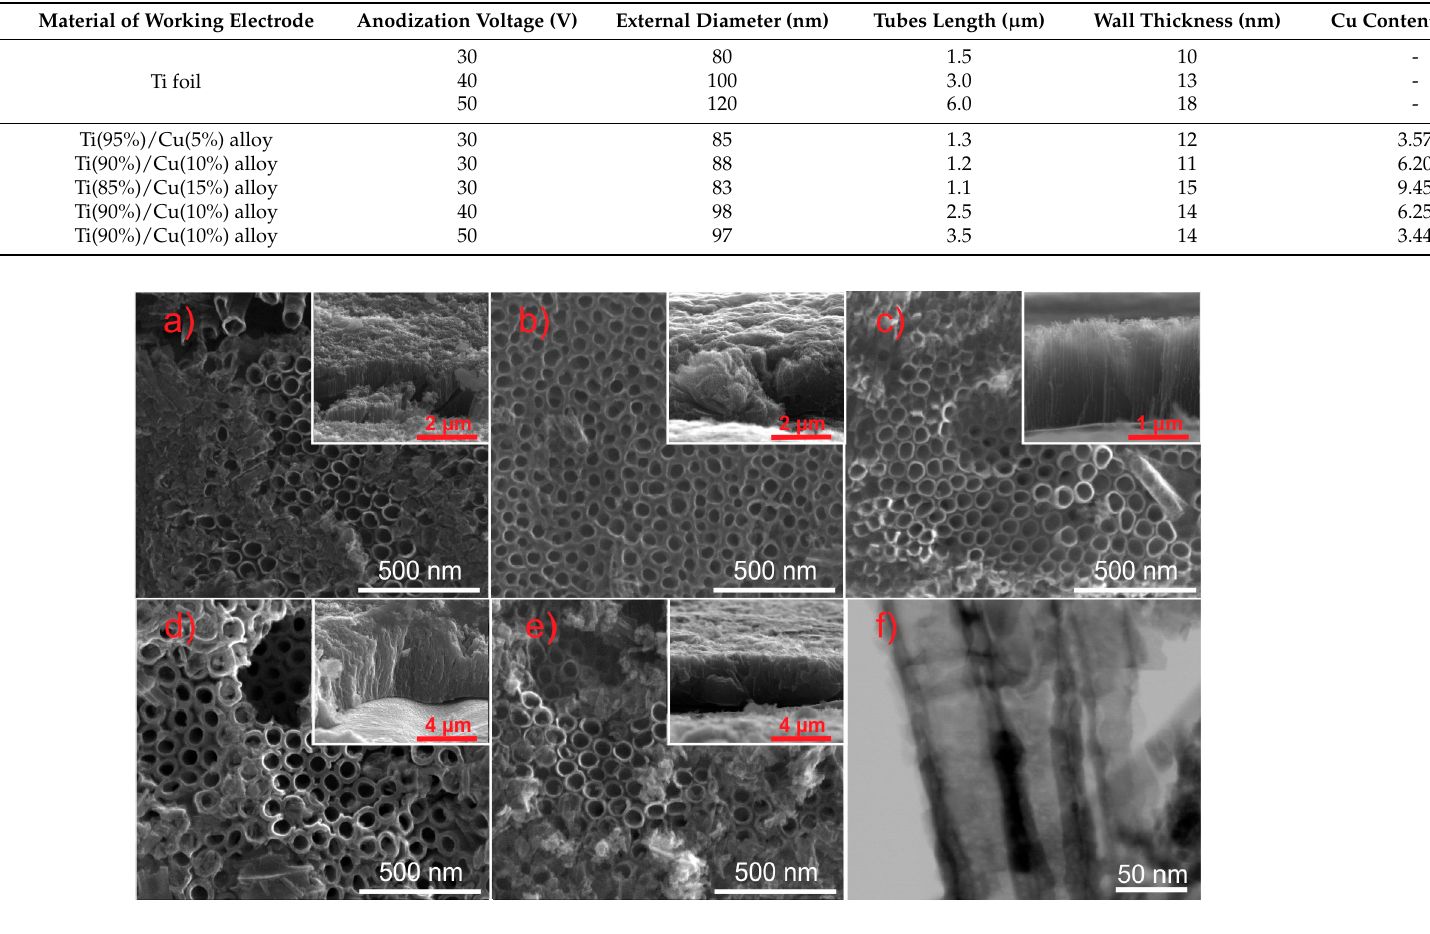
Table 1. Sample labels, preparation conditions, NTs dimensions (based on SEM measurements), and Cu content (based on EDX (Energy-dispersive X-ray spectroscopy)).